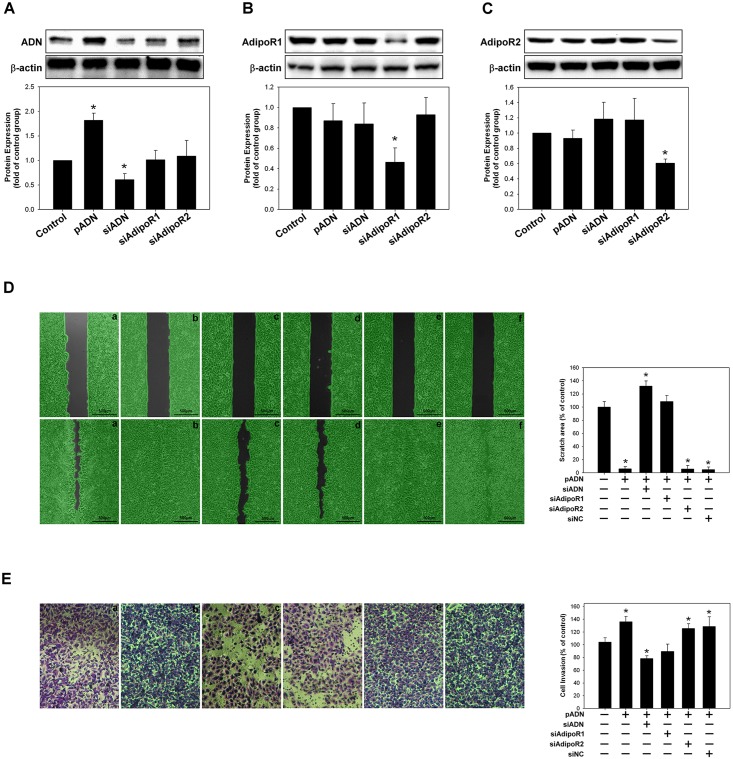
Adiponectin receptor 1 mediated the adiponectin effect on the migratory and invasive ability of A549 cells.
(A–C) The expression levels of adiponectin, adiponectin receptor 1, and adiponectin receptor 2 were analyzed by western blotting after transfection with adiponectin vector or silencing by siADN, siAdipoR1, and siAdipoR2. (D–E) The migratory and invasive ability of A549 cells was inhibited after silencing of the adiponectin receptor 1 expression by transfection with siAdipoR1.